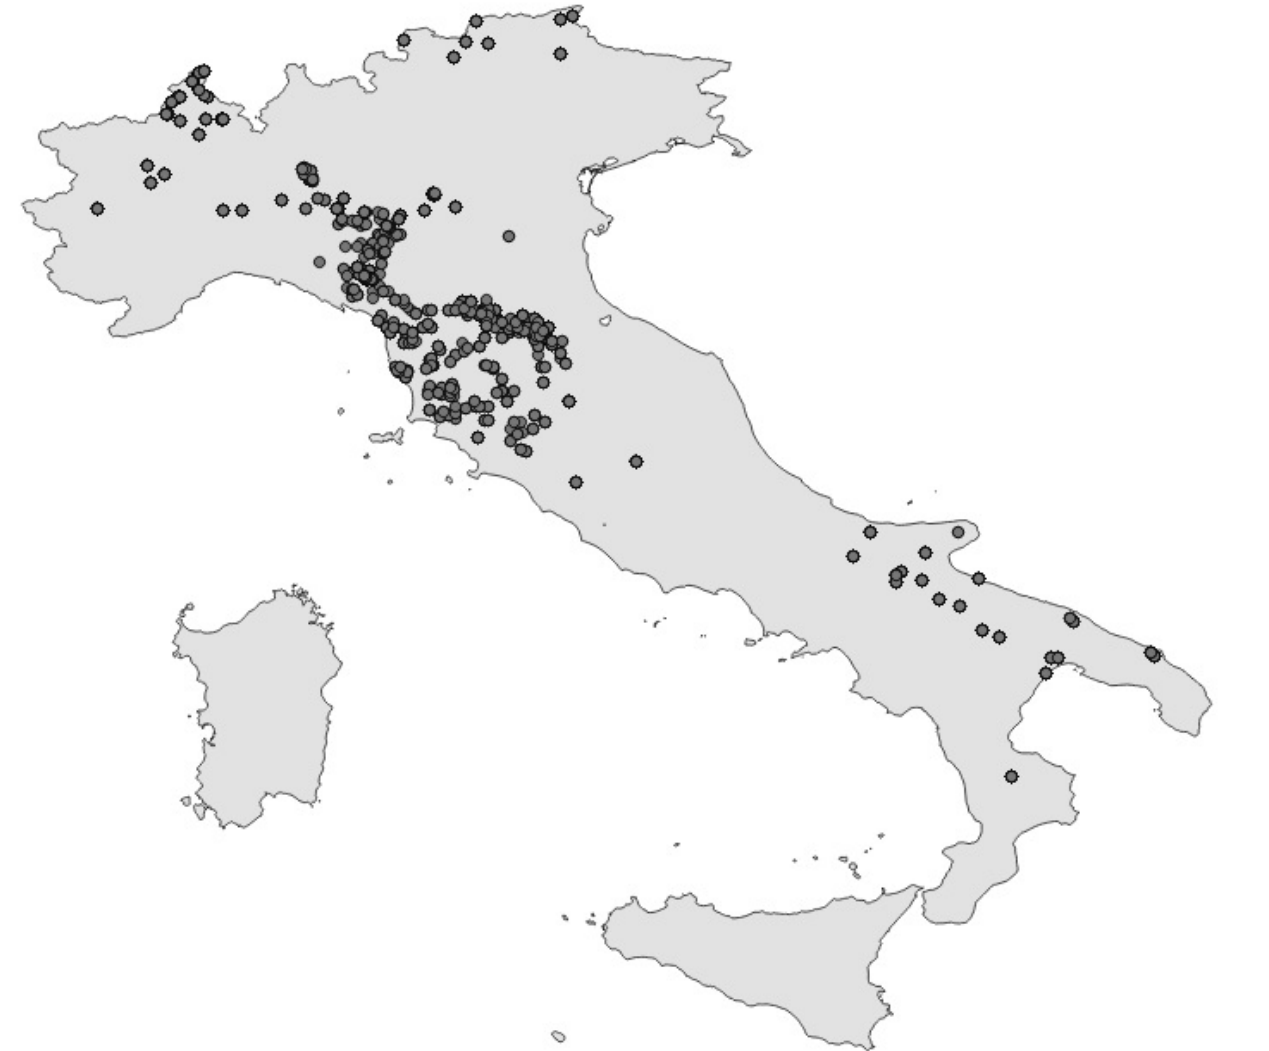
FIGURE 1. Sampling sites distributed along the Italian